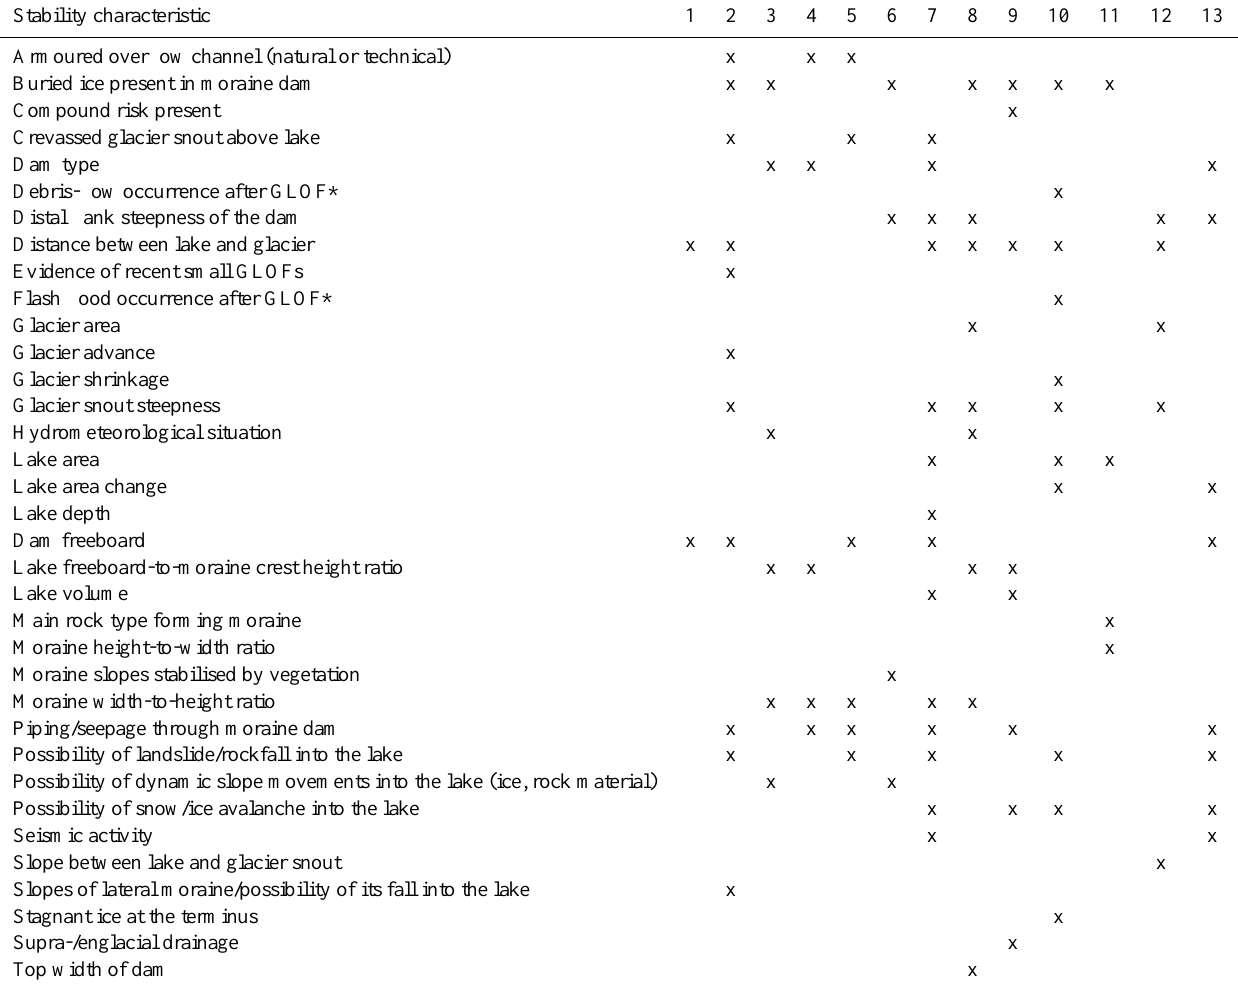
Table 2. The stability characteristics assessed in previous studies. Stability characteristic